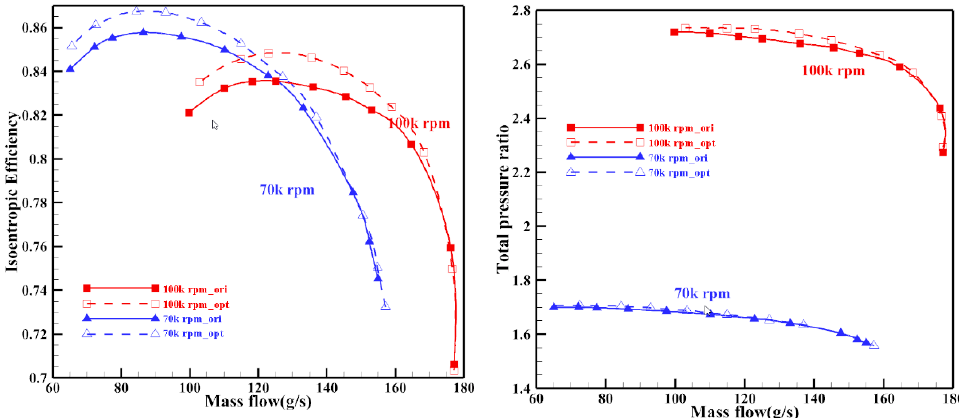
Figure 12. Aerodynamic performance curve at different conditions before and after opti ‐ misation.